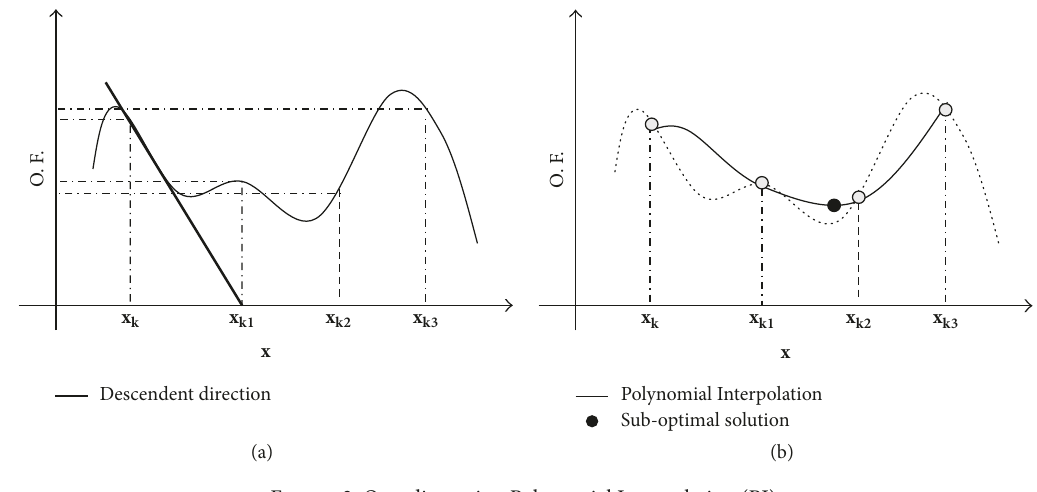
Figure 2: One-dimension Polynomial Interpolation (PI).